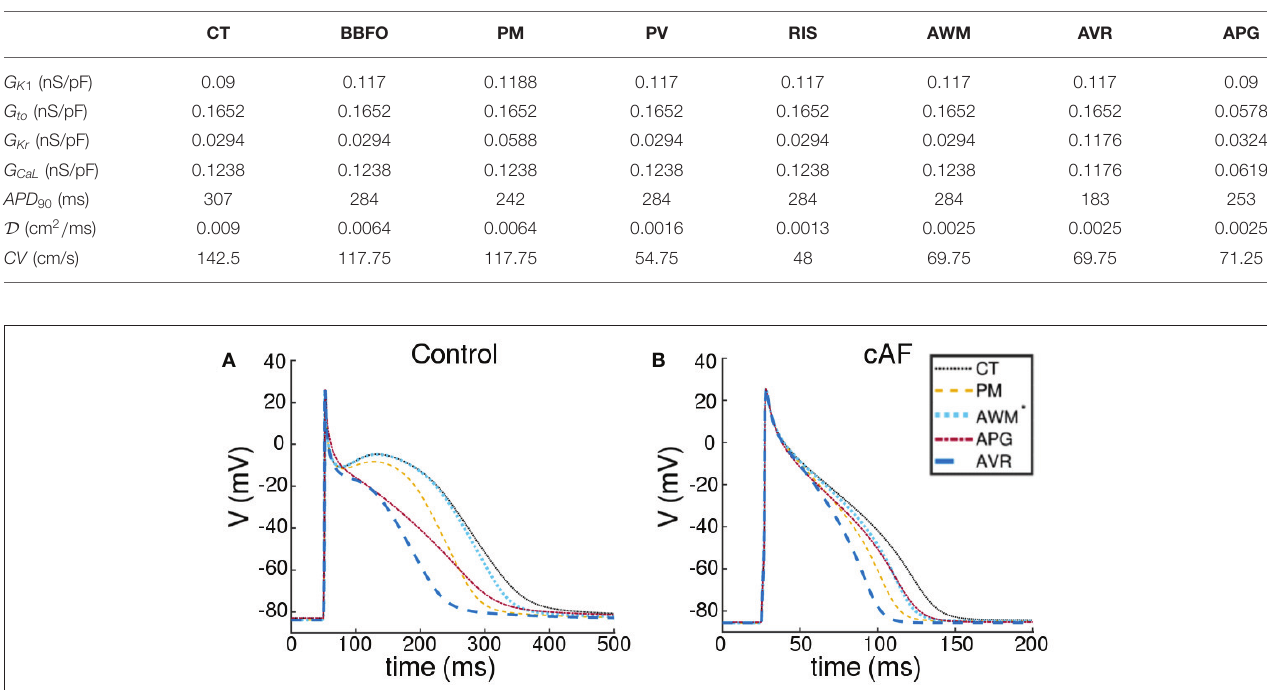
FIGURE 1 | Action potentials obtained using region-specific models for different parts of the atria, under (A) control and (B) chronic AF (cAF) remodeled conditions. The dotted black line represents the AP from crista terminalis (CT), the dashed orange line represents the AP from the pectinate muscle region (PM); the dashed maroon line represents the AP from left and right atrial appendages (APG), and the thick dashed blue line represents the AP from the left and right atrioventicular regions (AVR). The rest of the atria, i.e., the Bachmann’s bundle (BB), fossa ovalis (FO), pulmonary veins (PV), the isthmus of the right atrium (RIS) and the atrial working myocardium (AWM) is modeled using a single set of parameters. The corresponding AP is shown using a dotted blue line (AWM ∗